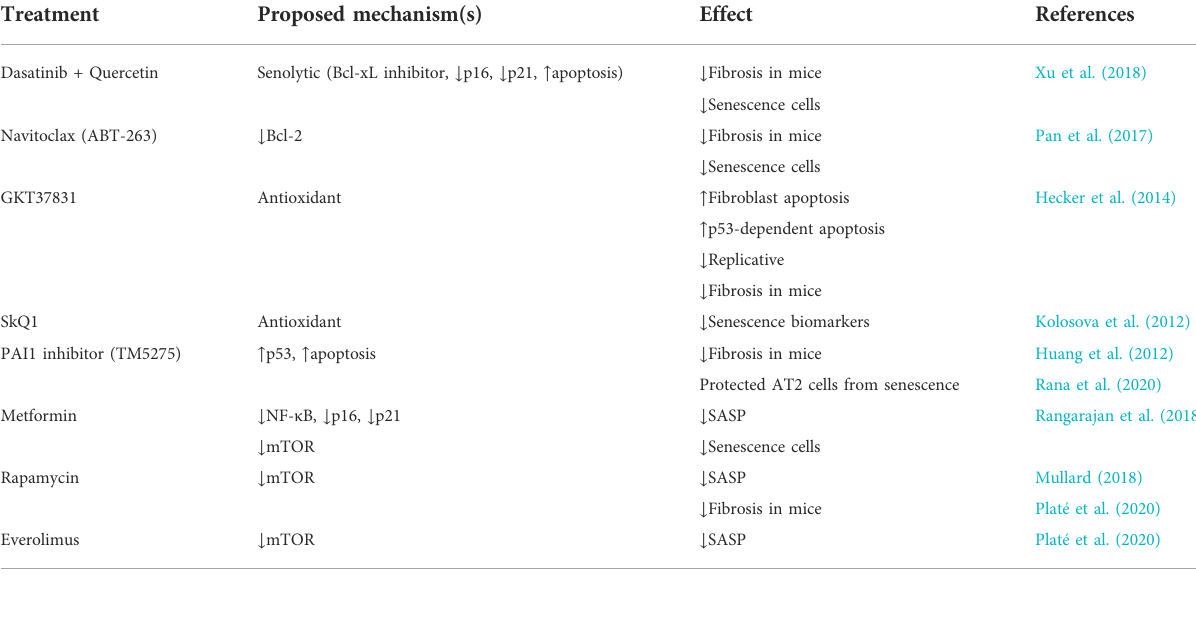
TABLE 1 Anti-senescence therapy with mechanism and effect in pulmonary fi brosis.